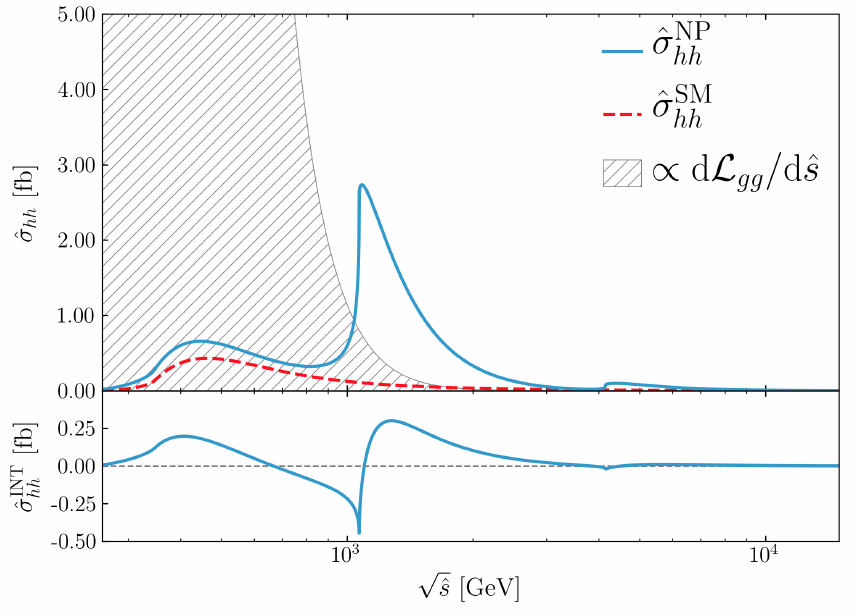
Figure 3. In the upper panel we have the Standard Model contribution (red dashed line) to the parton cross section of di-Higgs production in gluon fusion as a function of the center-of-mass energy of the gluon pair. Its modification by the presence of LQs (with masses of 535 GeV and 2076 GeV) is represented by the blue solid line. The shaded area is proportional to the gluon-gluon luminosity. In the lower panel we have the interference between the Standard Model and the LQ form